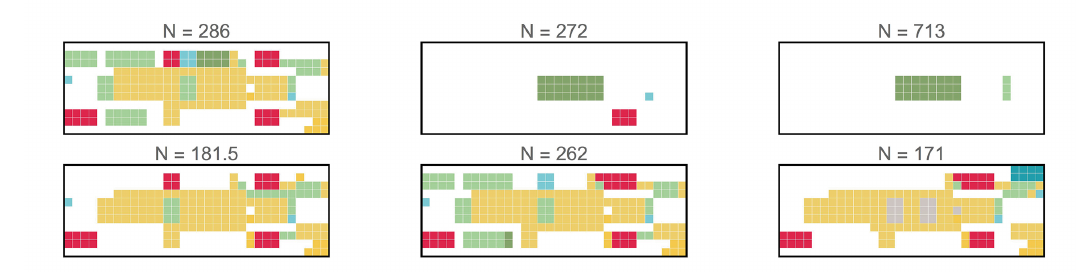
Figure 9. The test configurations with the corresponding number of